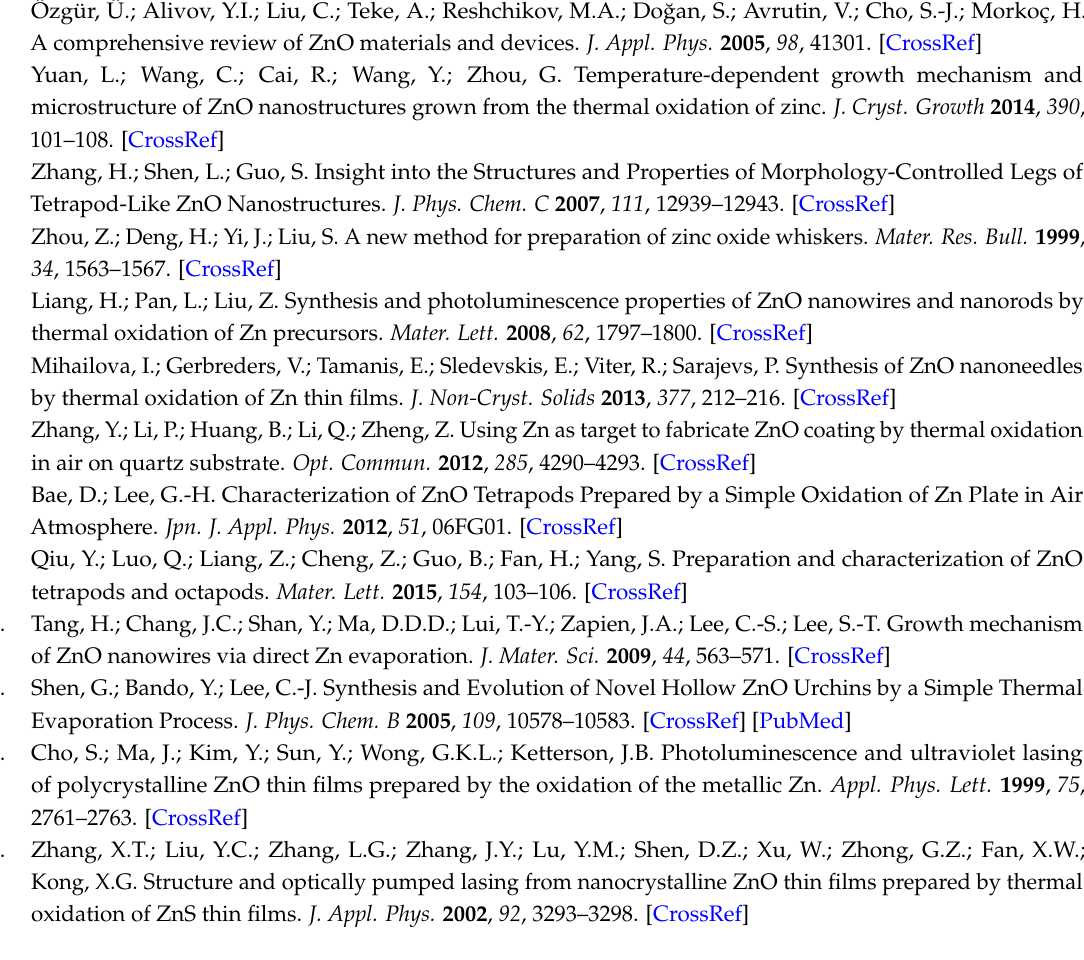
Figure S1: Time evolution of the experimental setup once the Zn powder precursor was exposed to thermal oxidation (900 ◦ C; air